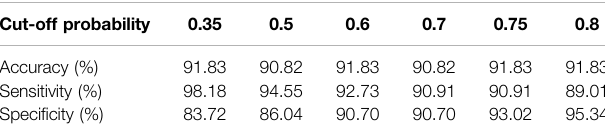
TABLE 3 | Performance of COVID-FACT for different values of cut-off